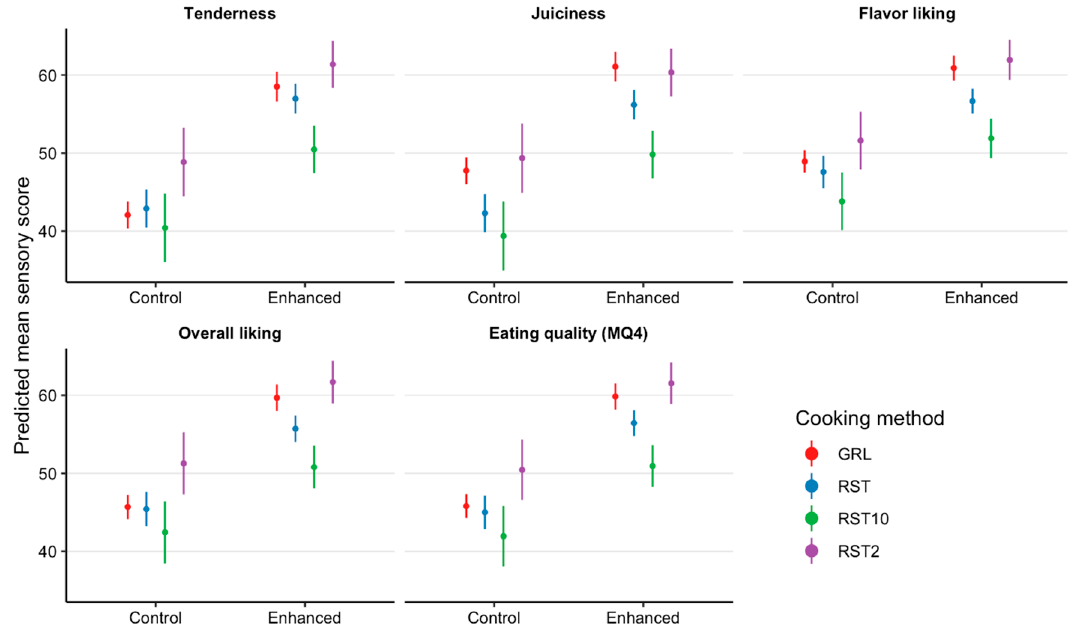
Figure 1. Estimated marginal means with 95% confidence intervals for tenderness, juiciness, flavor, overall liking, and eating quality (MQ4) scores of striploins ( M. longissimus lumborum ) and outside flats ( M. biceps femoris ) not infused (control) and infused with a kiwifruit extract (enhanced) presented to consumers ( n = 2080) as grill (GRL), 10 mm hot roast (RST), 2 mm cold roast (RST 2 ) and 10 mm cold roast (RST 10 ).